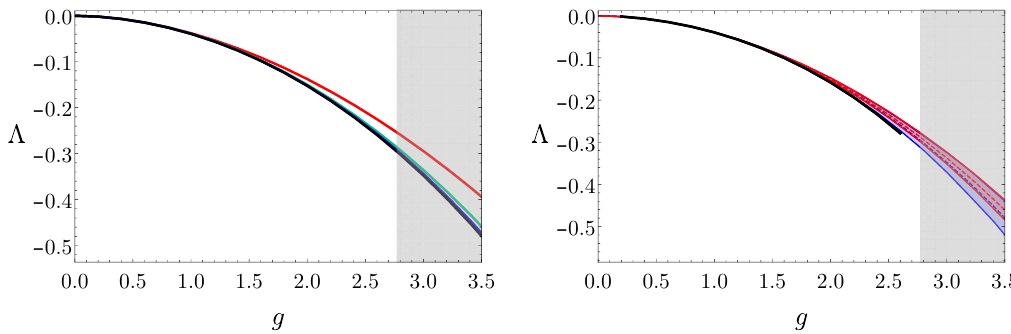
Figure 5 . (Left panel) The vacuum energy (cid:3) as a function of the coupling constant g using conformal mapping at di(cid:11)erent orders: N = 5 (red line), N = 6 (green line), N = 7 (blue line), N = 8 (black line). Errors are not reported to avoid clutter. The N = 7 and N = 8 lines are indistinguishable. (Right panel) Comparison between the results obtained using conformal mapping at N = 8 (light blue), Pad(cid:19)e-Borel approximants (light red) and the results of ref. [14]